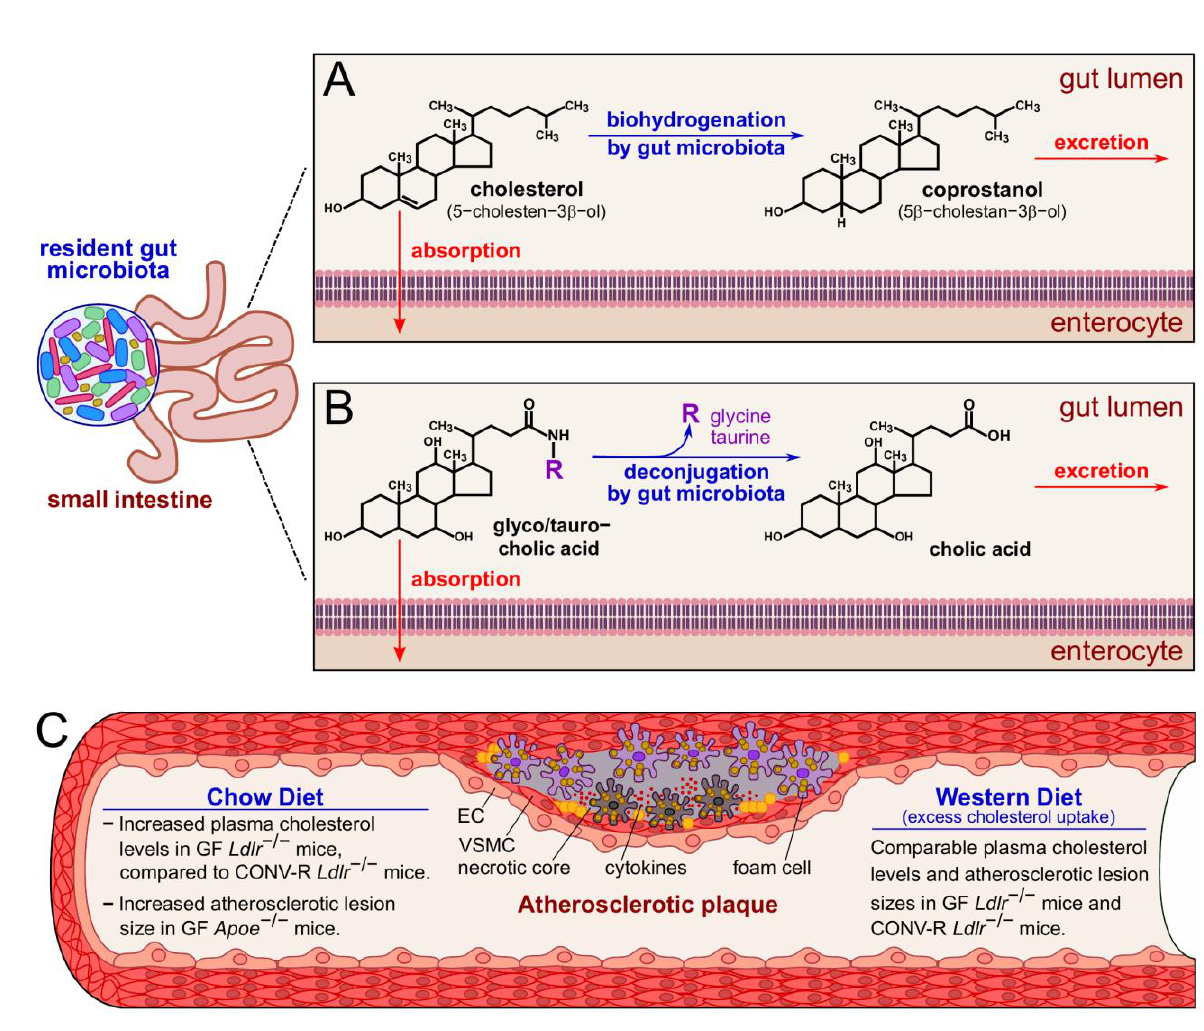
FIGURE 1: Impact of the gut microbiota on cholesterol and bile salt excretion and on and atherosclerotic lesion size under chow diet or Western diet. (A) In the gut lumen, the biohydrogenation activity of the gut microbiota converts cholesterol into the more hydrophilic co- prostanol. (B) The gut microbiota is able to deconjugate both the bile salts glycocholic and taurocholic acids to cholic acid. Coprostanol and cholic acid are readily excreted with the feces. (C) In blood vessels, a surplus of circulating cholesterol promotes the formation of athero- sclerotic plaques, characterized by an accumulation of smooth muscle cells and macrophages that convert into foam cells. Excess of foam cells leads to apoptosis, necrotic core formation and, eventually, plaque rupture. At chow diet conditions, the gut microbiota prevents cho- lesterol accumulation, and indeed GF Ldlr -/- and GF Apoe -/- mice have increased plasma cholesterol levels compared to CONV-R controls. At chow diet conditions, GF Apoe -/- mice show increased atherosclerotic lesion size, compared to CONV-R counterparts. On the other hand, excess cholesterol uptake at Western diet conditions counteracts the protective effect of the gut microbiota, and GF and CONV-R Ldlr -/- mice show comparable plasma cholesterol levels and atherosclerotic lesion sizes. Abbreviations: EC, endothelial cell; VSMC, vascular smooth muscle cell; GF, germ-free; CONV-R, conventionally